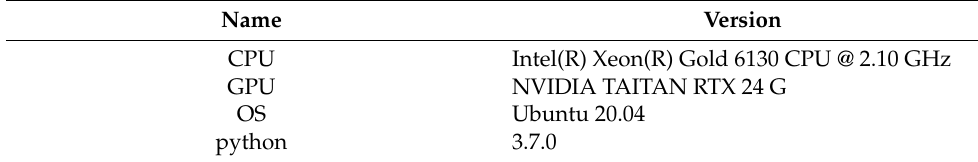
Table 3. Platform configuration